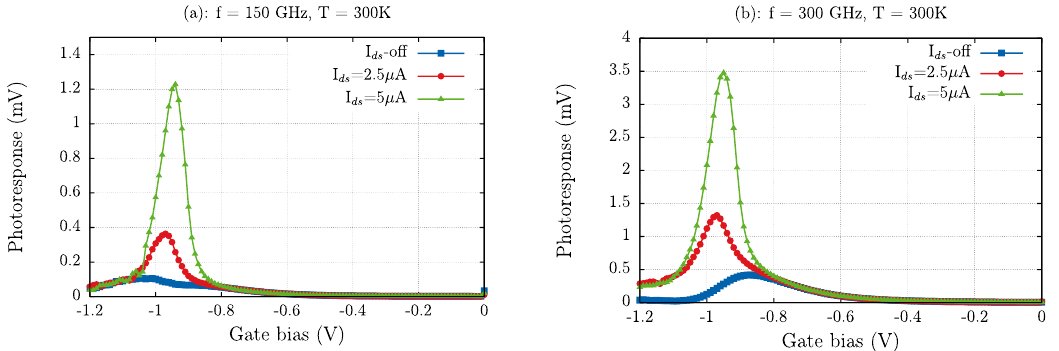
Figure 8. ( a ) Experimental THz photoresponse of the strained-Si MODFET in the photovoltaic mode ( I ds -off) and for two values of the bias source-to-drain current ( I ds = 2.5 μA, I ds = 5 μA) under an excitation of 150 GHz; ( b ) same as ( a ) under an excitation of 300 GHz.